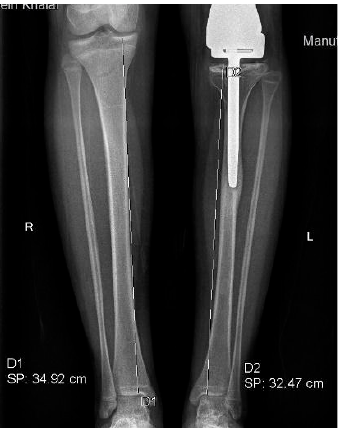
Figure 4. Tibial length discrepancy of 24.5 mm in one of our patients.